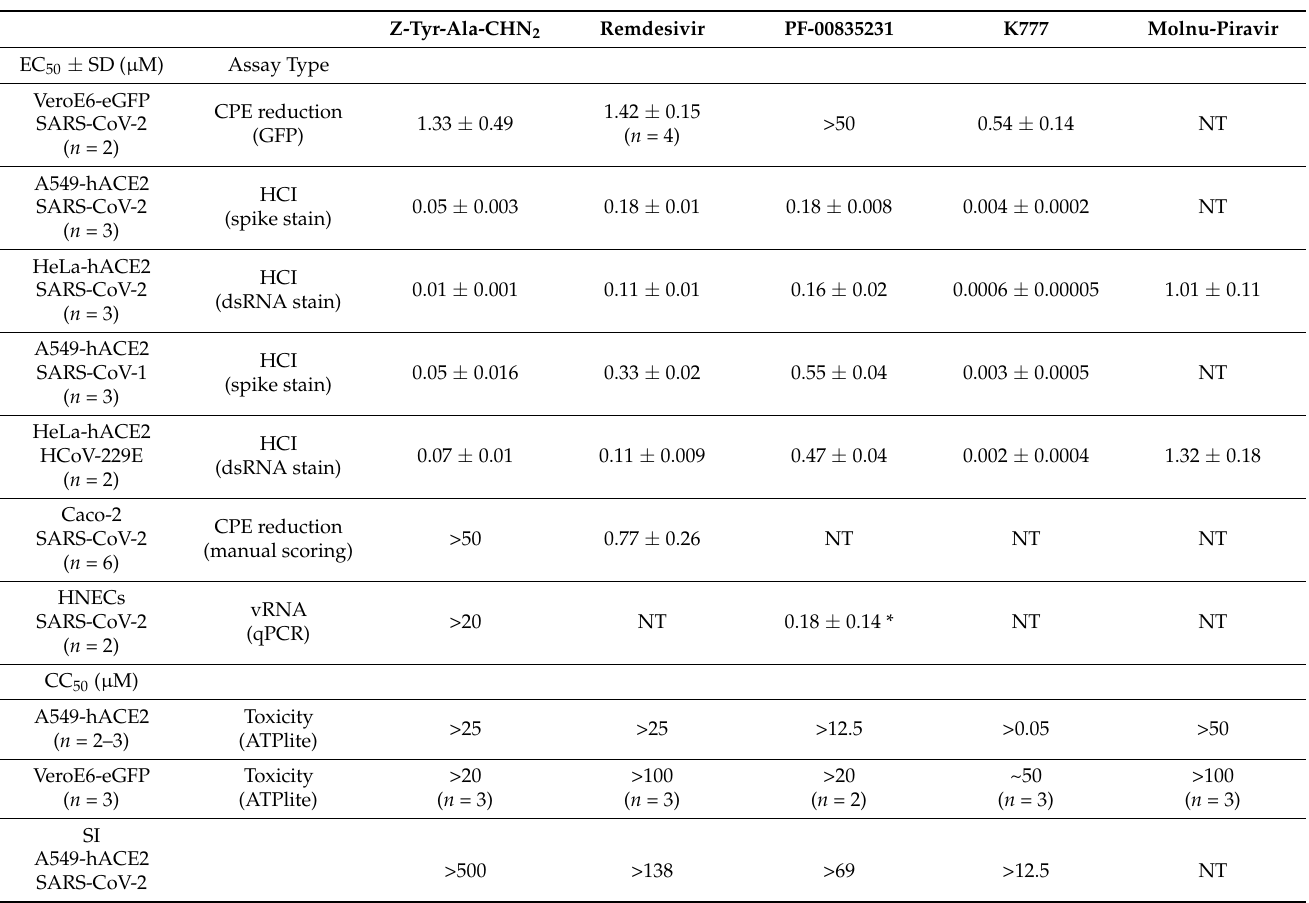
Table 1. EC 50 and CC 50 values ± SD and SI values of antiviral agents tested by cellular background and virus